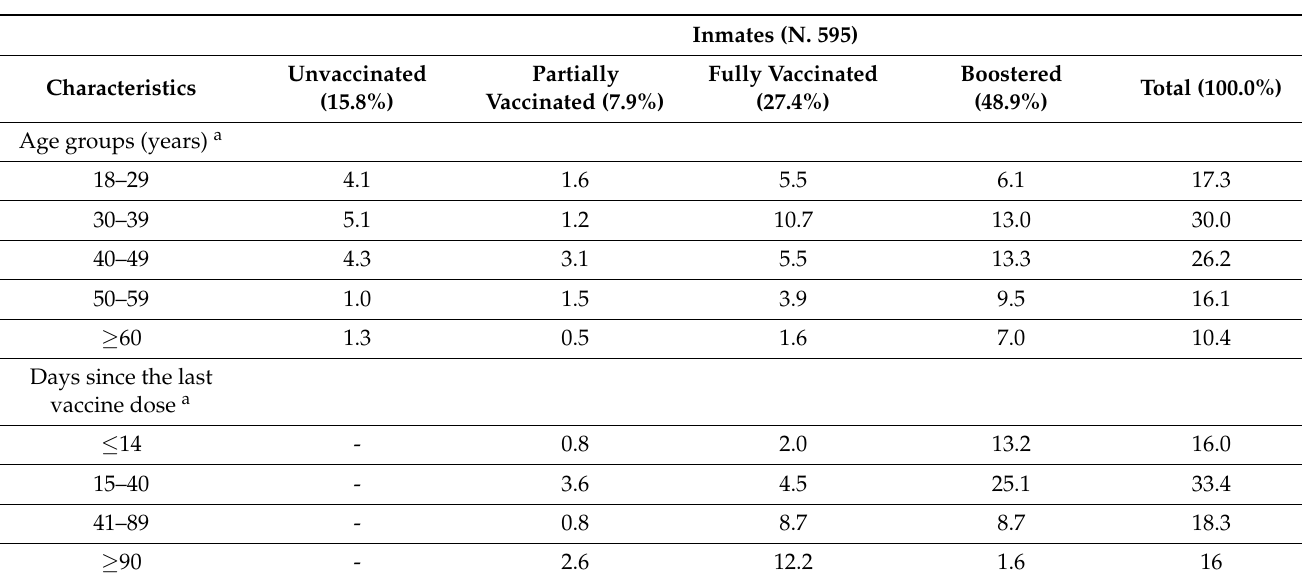
Table 1. Age, days from the last dose of vaccine, and vaccination status among the inmates partici- pating to the screening campaign during the study